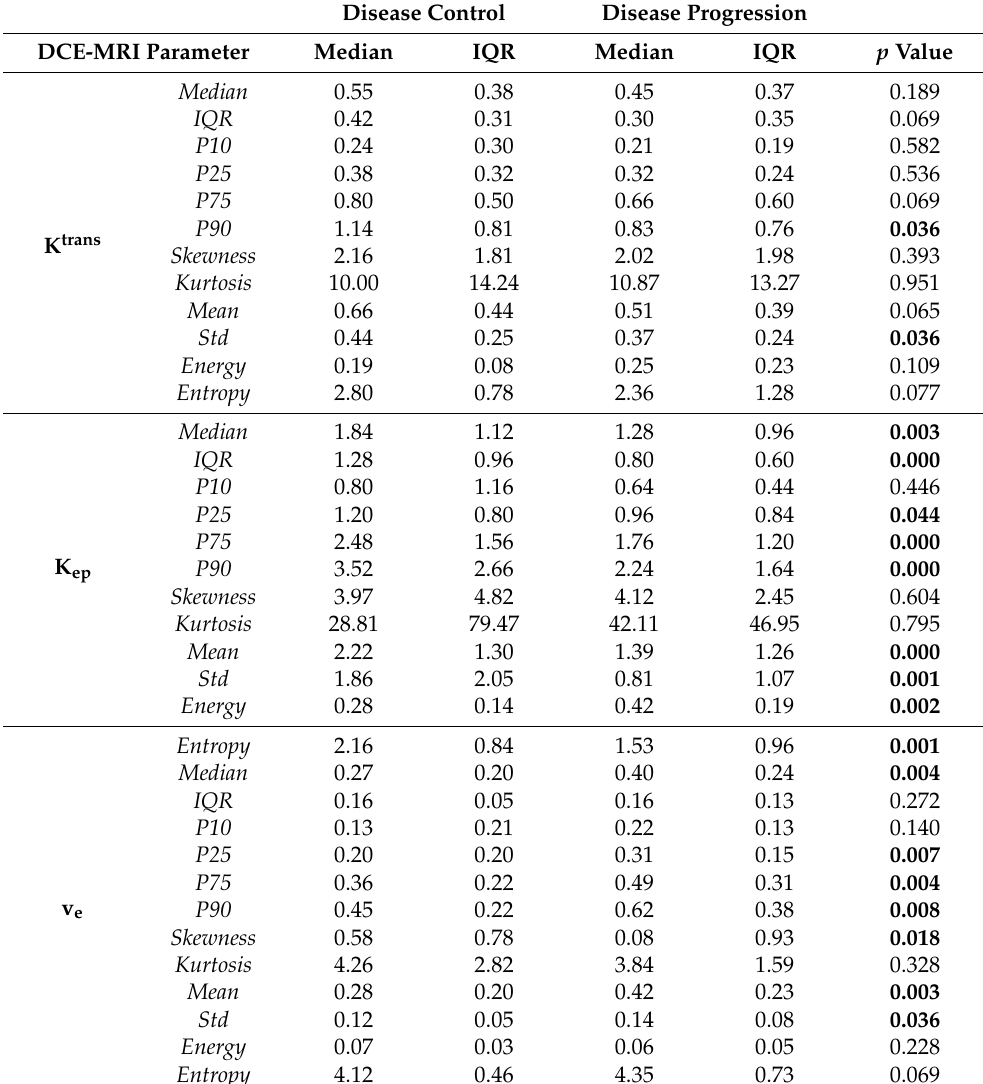
Table 4. Summary statistics of DCE-MRI parameters in the lymph node (N) for patients with and without disease